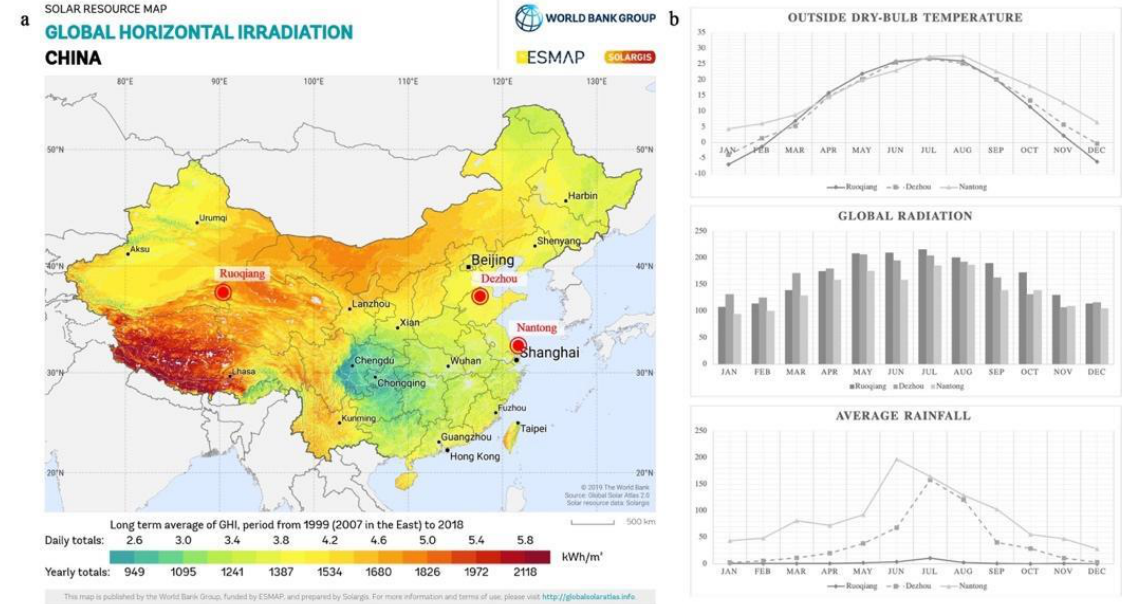
Figure 3 (a) Global irradiance in China and selected cities (Solar GIS, 2019); (b) Outside dry-bulb temperature, global radiation, and average rainfall of Ruoqiang, Dezhou, and Nantong (EnergyPlus, 2005; Weather Atlas,